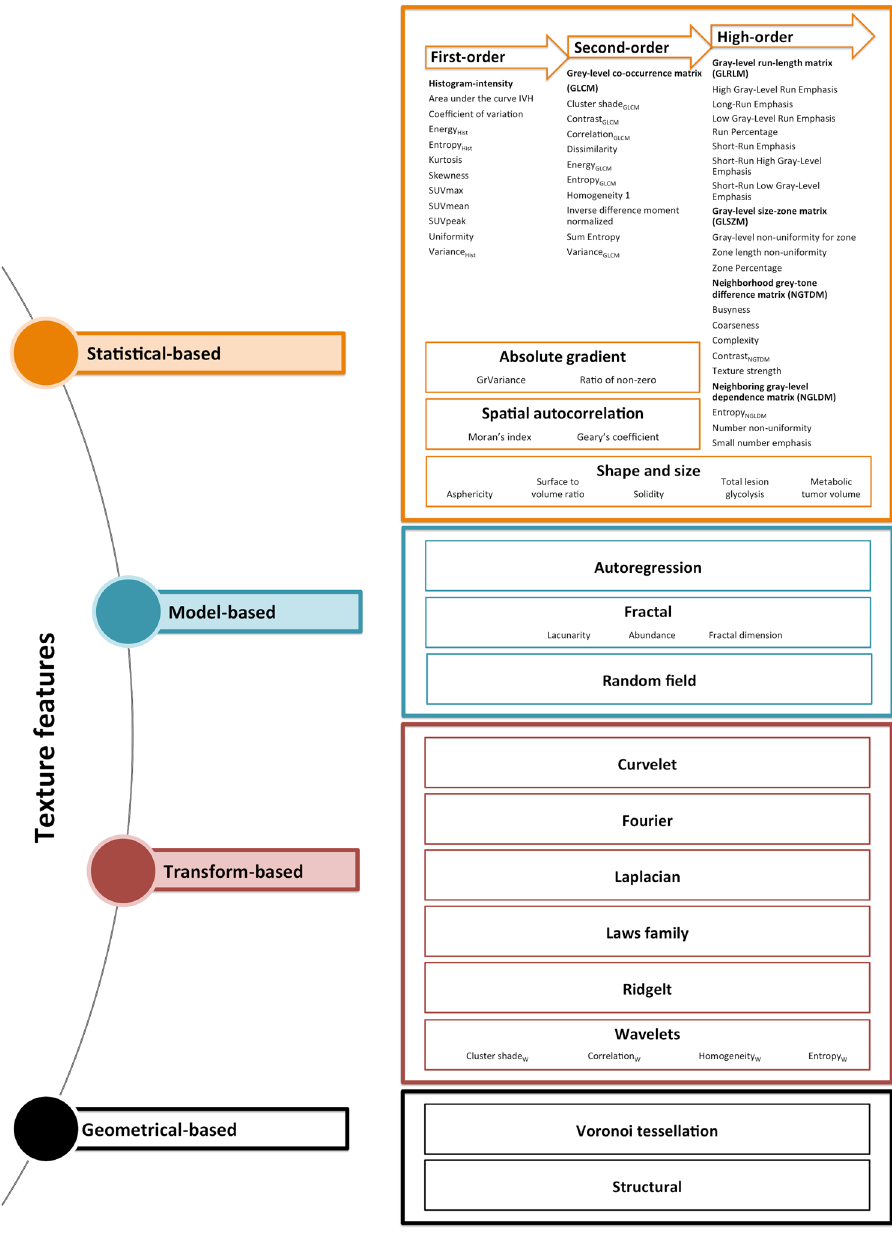
Figure 2. Methodological approaches in image texture analysis (the most frequently evaluated PET features in lung cancer patients are reported as